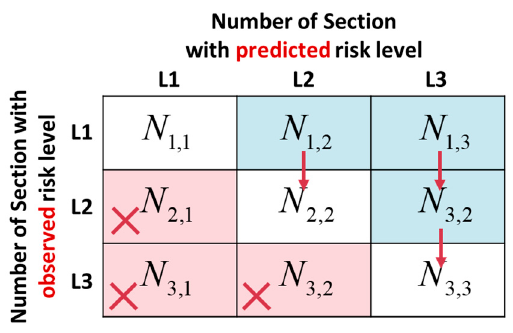
Figure 3. Three-category confusion matrix in this study.